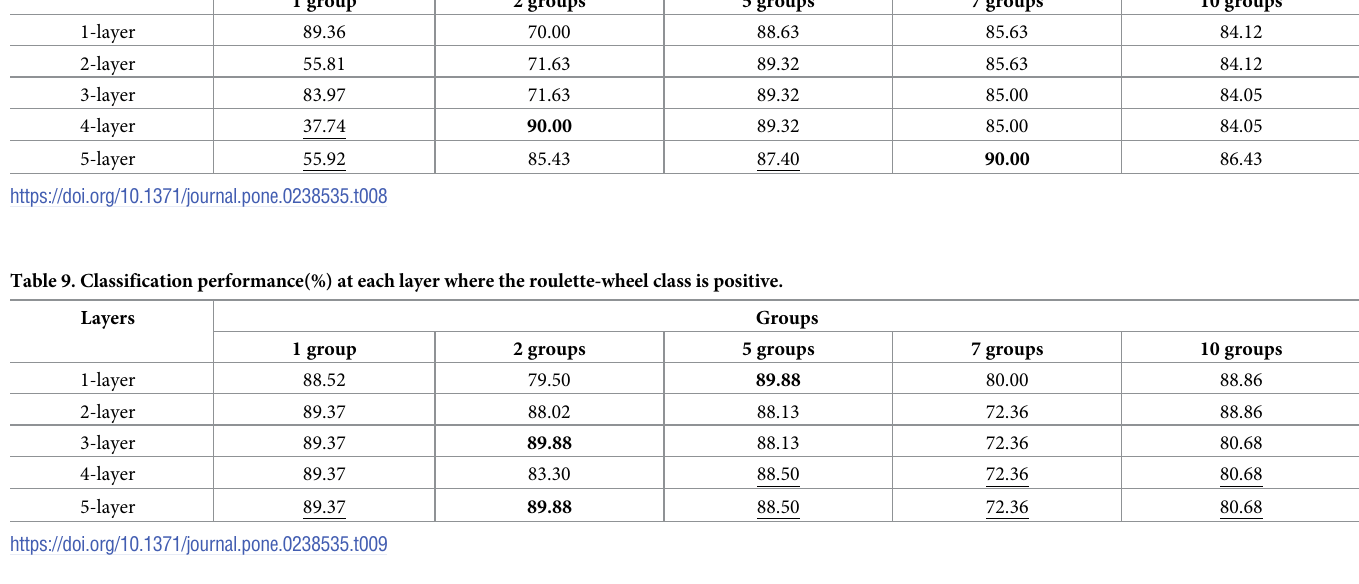
Table 8. Classification performance(%) at each layer where the desk-globe class is positive. Layers